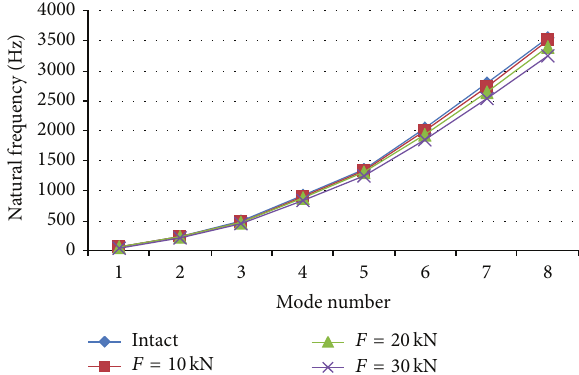
Figure 6: Experimental natural frequencies (Hz) for the simply supported beam subjected to static loading.